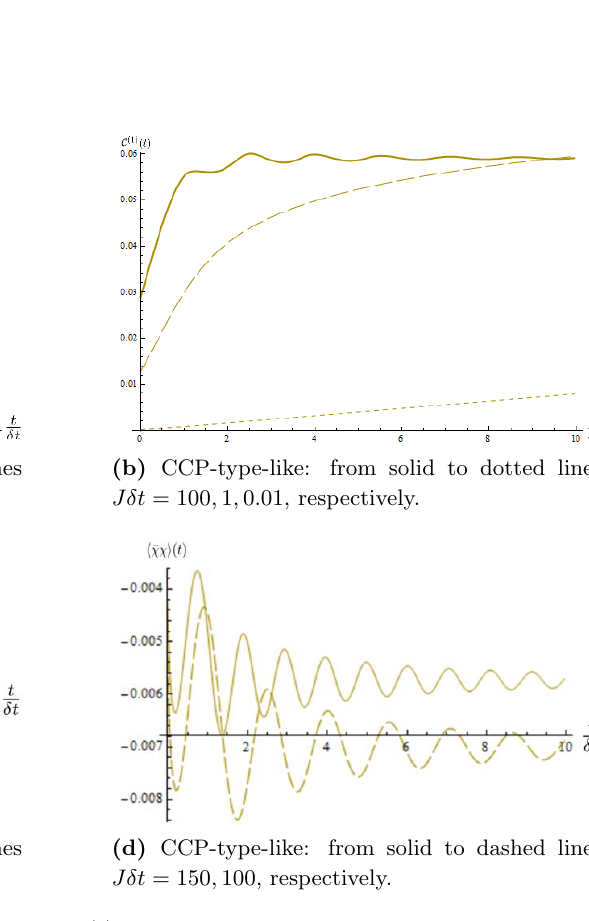
Figure 6. 6a & 6b: time evolution of complexity time evolution of ¯ χχ in ECP and CCP-like potentials. From thick solid lines to dotted lines Jδt (cid:30) (cid:29) decrease. Choose b = 0 .